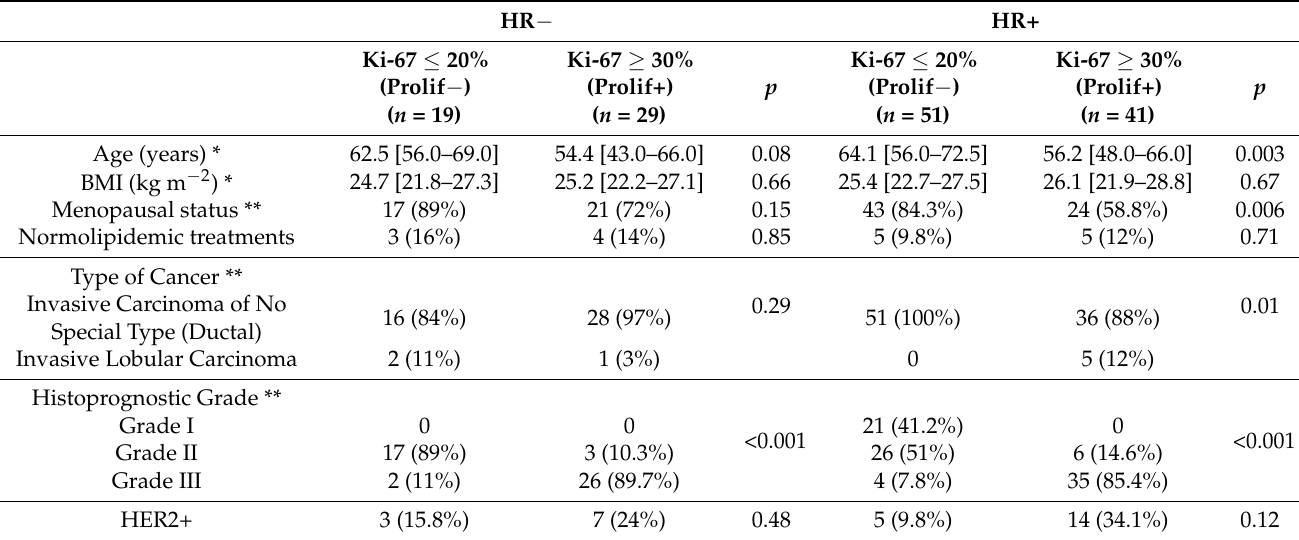
Table 1. Clinicobiological parameters of the studied